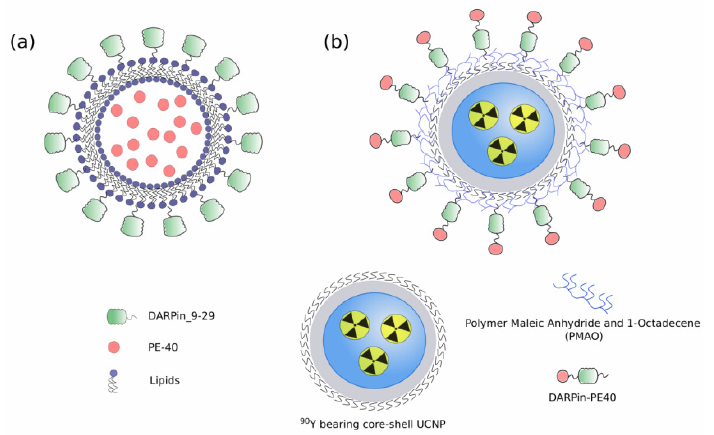
Figure 2. ( a ) Small unilamellar targeted liposomes containing PE40 [93]; ( b ) Hybrid biofunctional nanocomplex based on radioactive 90Y bearing core-shell UCNP and functionalized with targeted toxin DARPin-PE40 [97].